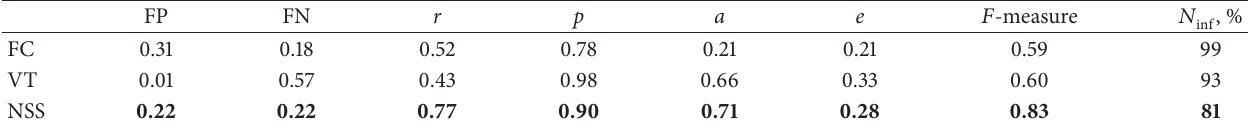
Table 1: Comparison of the protection mechanisms FC, VT, and NNS.